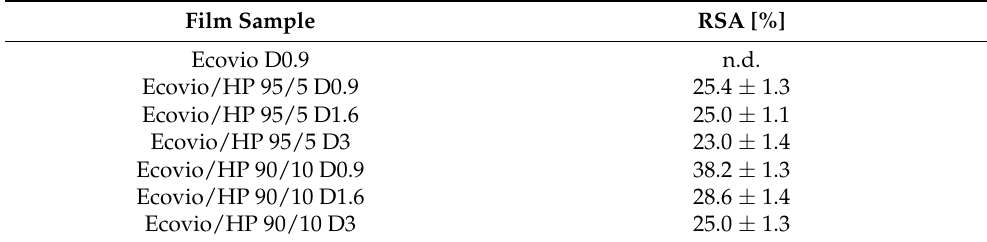
Table 8. Radical scavenging activity (RSA%) of Ecovio/HP 95/5 and Ecovio/HP 90/10 active films with different average